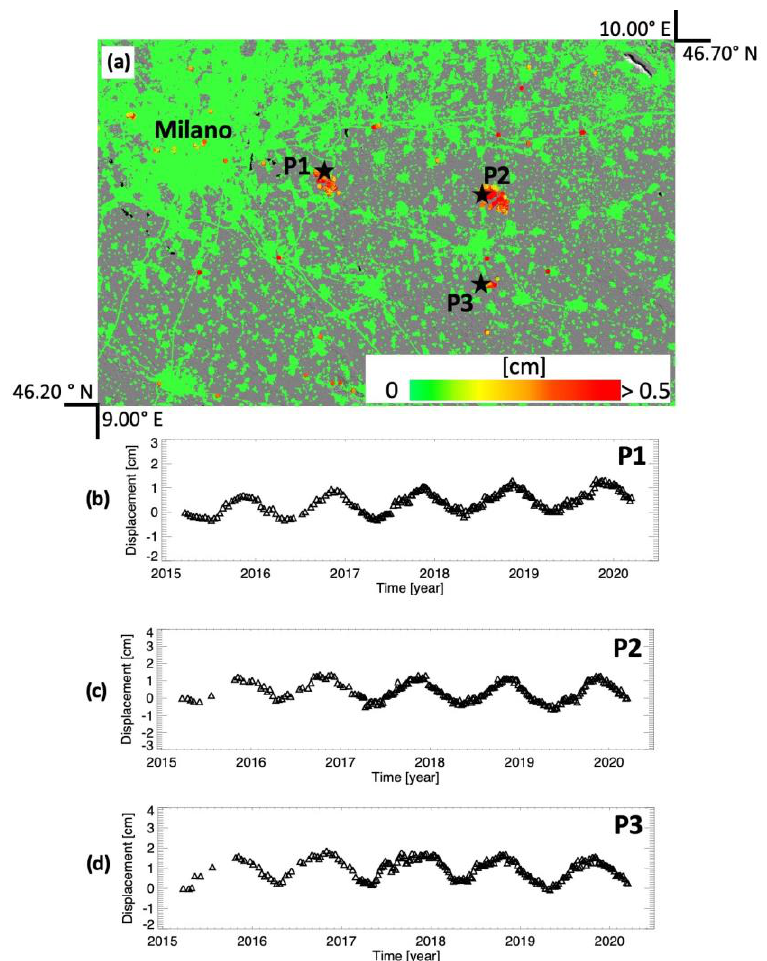
Figure 17. Correlation map between DInSAR time series and an annual sinusoid relevant to an area located in Northern Italy, close to the city of Milano. ( a ) Peak-to-peak oscillation amplitude map superimposed on the SRTM DEM of the zone. Note that pixels with peak-to-peak amplitude values equal to 0 are those for which the correlation coefficient is smaller than 0.8. ( b – d ) Displacement time series relevant to the pixels P1, P2 and P3, marked by the black stars in the map, located in correspondence to the Settala, Sergnano and Ripalta Guerina gas storage sites, respectively.